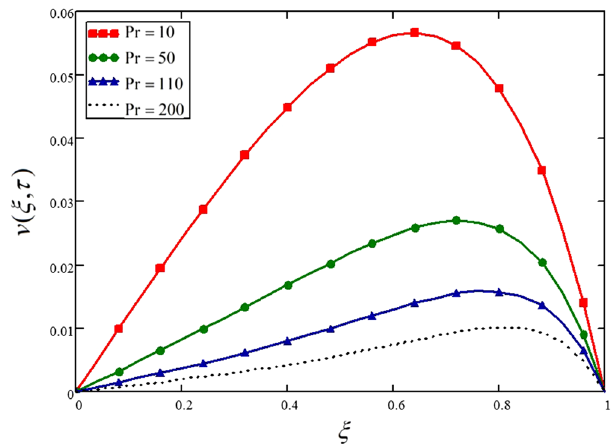
Figure 7. Influence of Prandtl number on the nanofluid